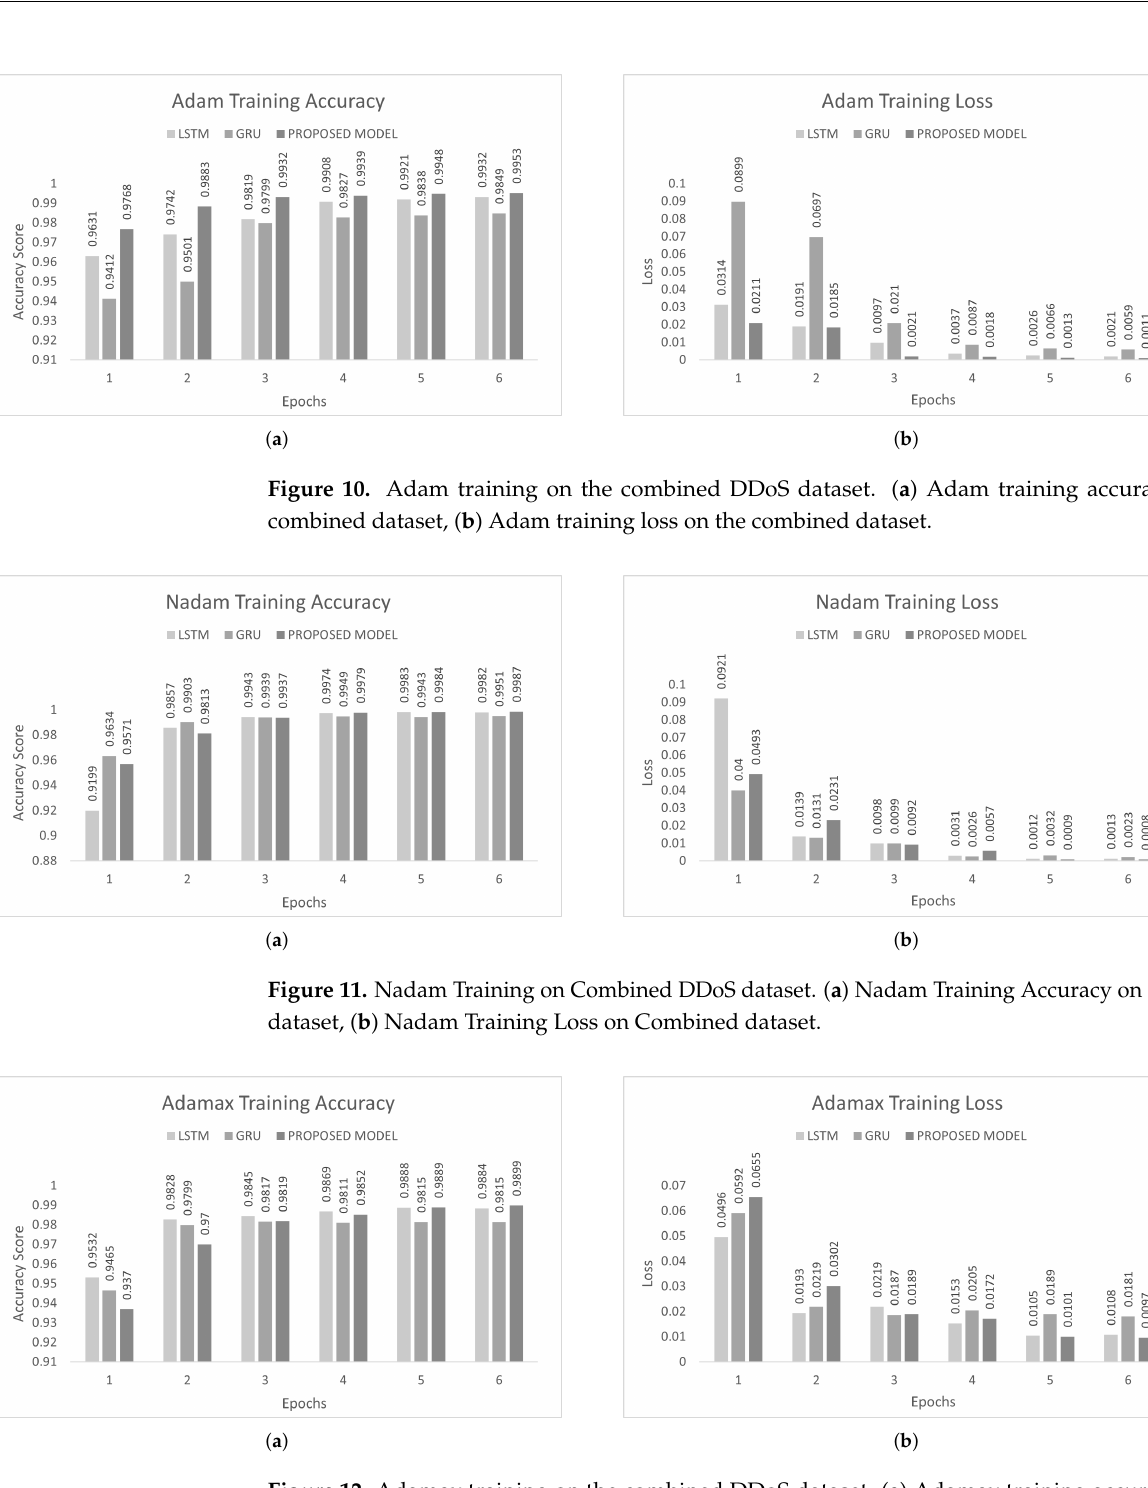
Figure 12. Adamax training on the combined DDoS dataset. ( a ) Adamax training accuracy on the combined dataset, ( b ) Adamax training loss on the combined